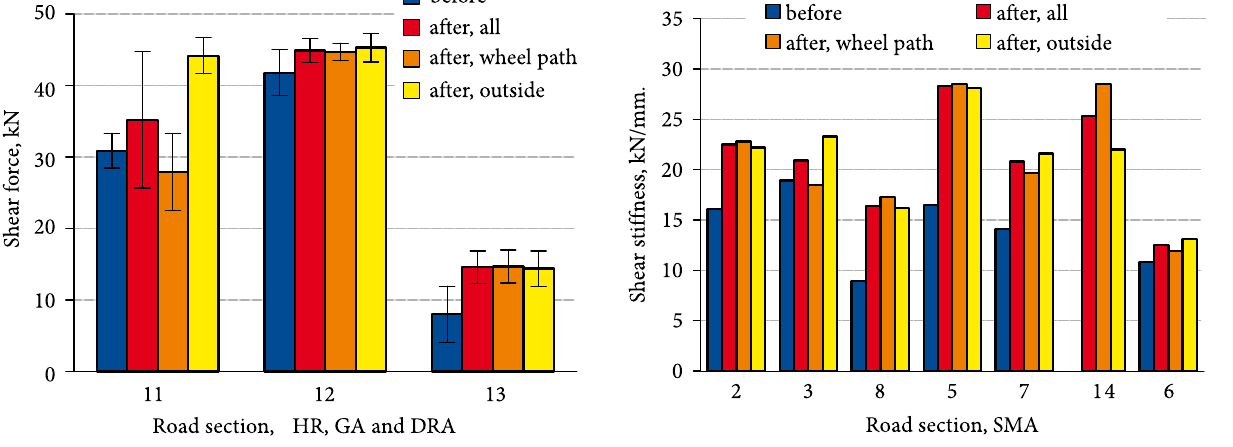
fig. 4. Comparison of shear forces at 20 °C directly after construction and after several years of traffic for all road sections with HR, GA and DRA surface courses